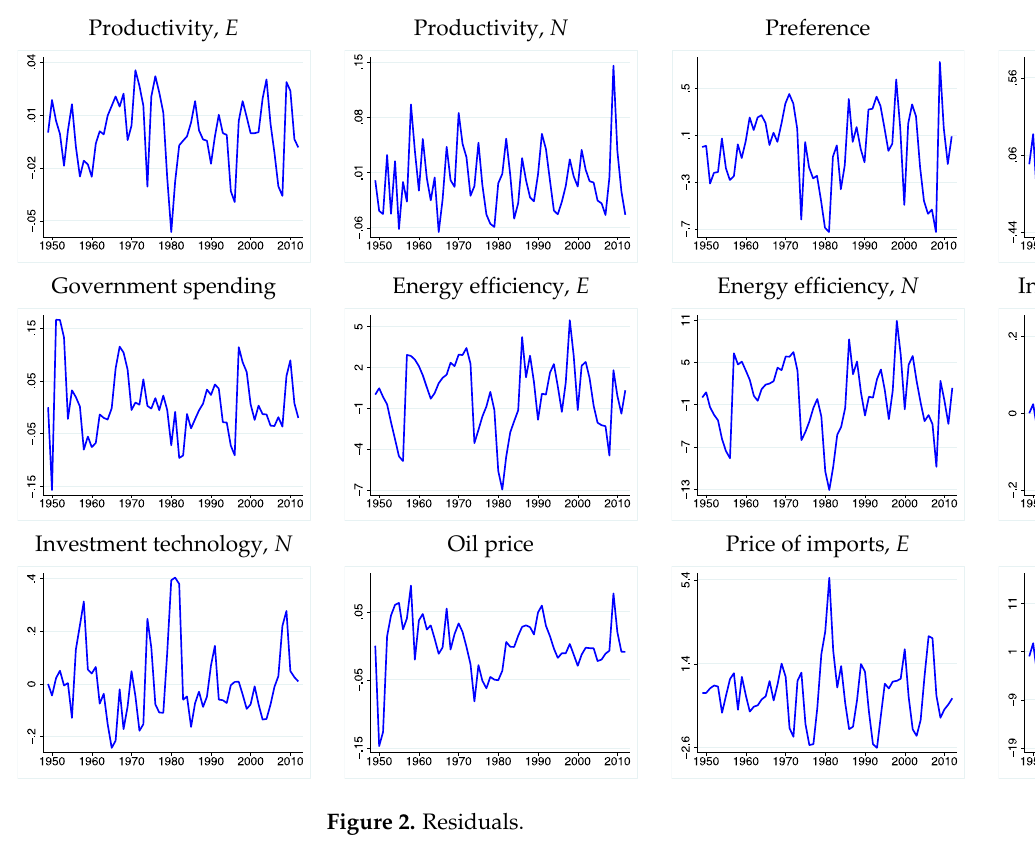
Figure 2. Residuals.